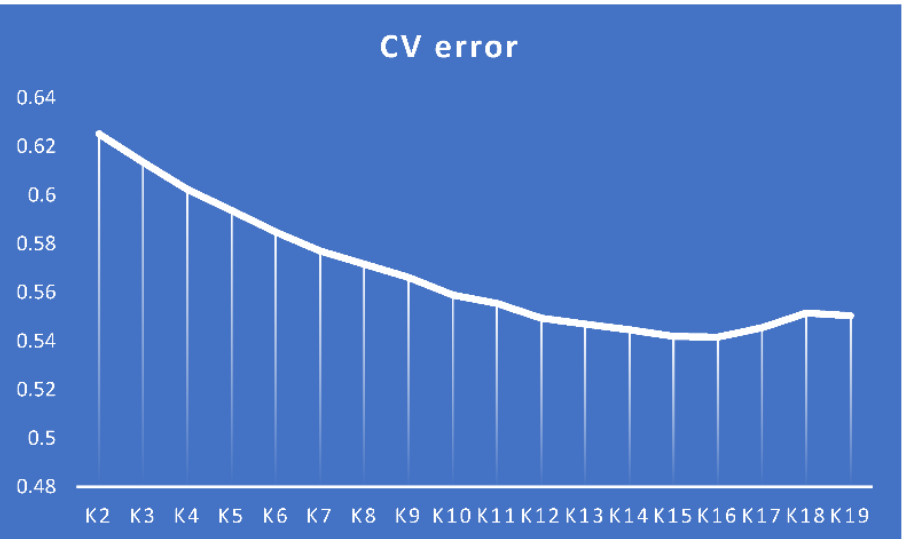
Figure 5. Cross-validation (CV) error in the Admixture analysis based on SNP genotypes in 18 chicken breeds. The optimal number of ancestral populations was K = 16.